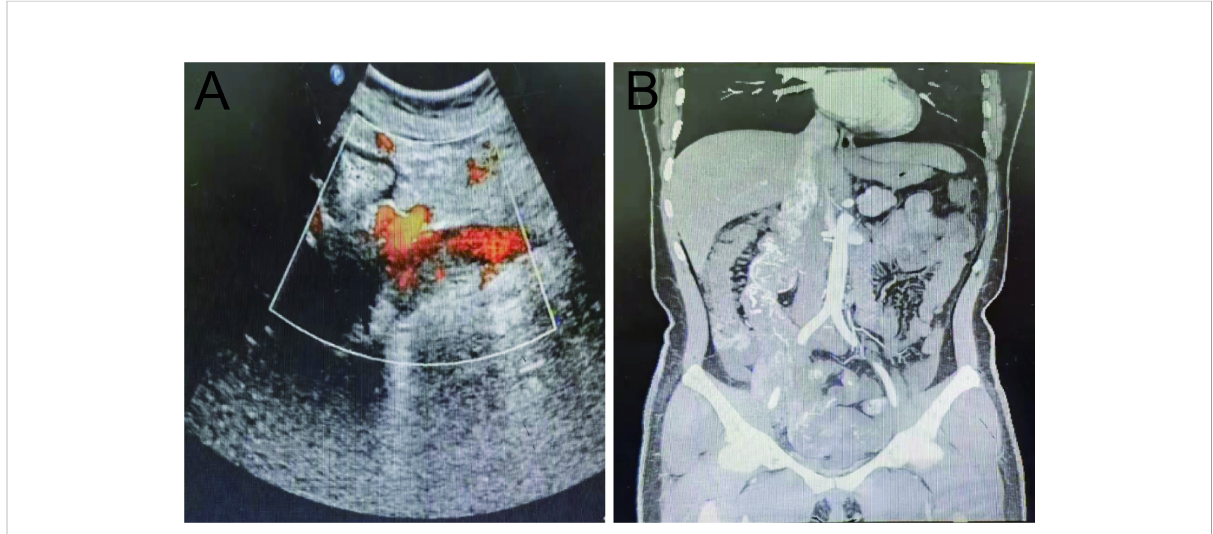
FIGURE 1 Preoperative pelvic ultrasound and abdominal CTA. (A) Preoperative pelvic ultrasound. (B) Preoperative abdominal